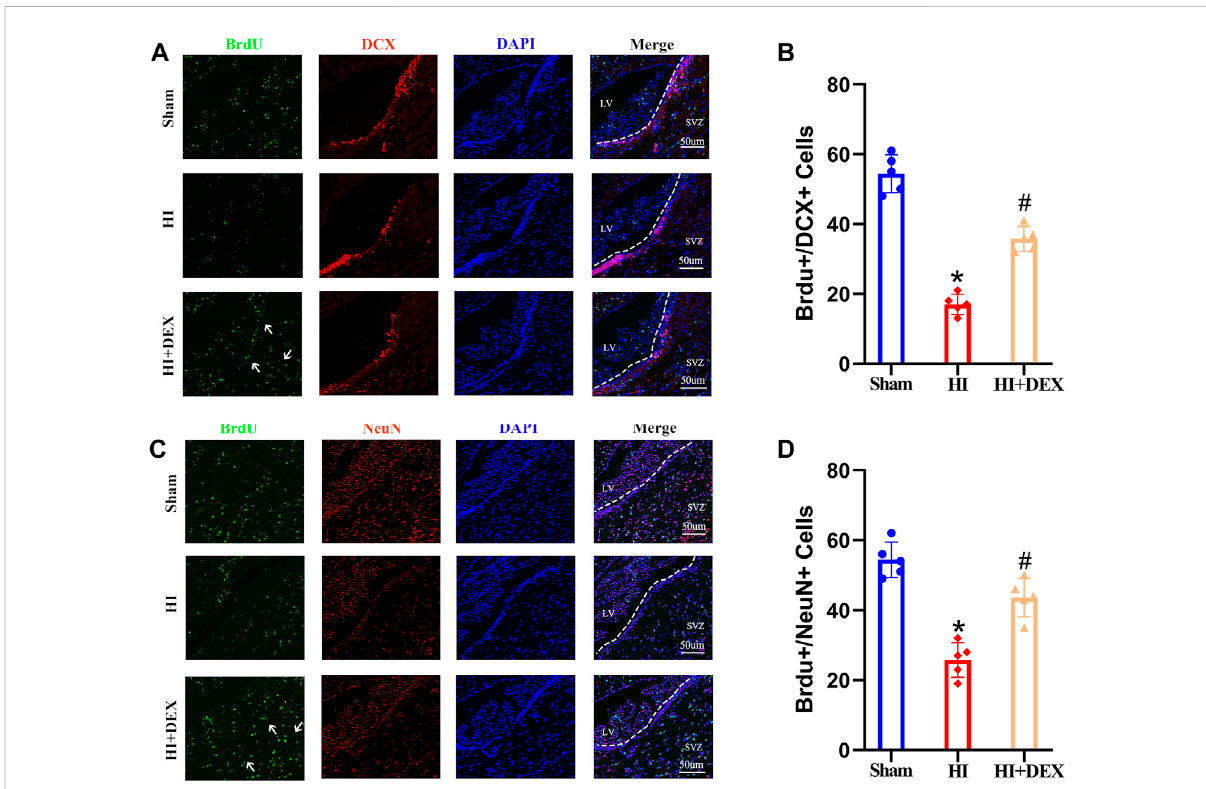
FIGURE 3 DEX promoted neurogenesis in the SVZ after HIBD. Neonatal HIBD was induced in rats on PND7. DEX (25 μ g/kg) was administered directly by intraperitoneal injection after the onset of HIBD. BrdU was administered daily for three consecutive days starting on day 4 (D4). Rats in the sham group, HI group and HI + DEXgroup weretrans-cardially perfused with paraformaldehyde and brain sections were taken on D14 and D28. The brain sections on D14 were double labeled with anti-BrdU (green) and anti-DCX (red) antibodies to detect newly formed neuroblasts. The brain sections on D28 were double labeled with anti-BrdU (green) and anti-NeuN (red) antibodies to detect newly formed neurons. (A,B) Representative images were captured using a laser scanning confocal microscope (magni fi cation ×400, scale bar: 50 μ m). The white arrows highlight a signi fi cant increase in the number of positive cells. (C,D) Statistical analysis of double-positive cells showed that the newly formed neuroblasts and newly formed neurons were signi fi cantly reduced in the SVZ of the ipsilateral injured hemisphere in neonatal rats caused by HIBD. This phenomenon was signi fi cantlyreversedbyDEX.DEX,Dexmedetomidine;SVZ,Subventricularzone;LV,Lateralventricle;HIBD,hypoxic-ischemicbraindamage;PND7, Postnatal day 7; D4, D14, D28: 4, 14, 28 Day after HIBD; HI, hypoxic-ischemia; The data are expressed as the mean ± SD ( n = 5 per group). * p < 0.05 vs. the sham group; # p < 0.05 vs. the HI